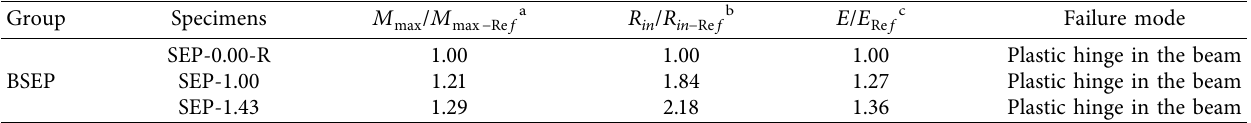
Table 5: Comparison of test